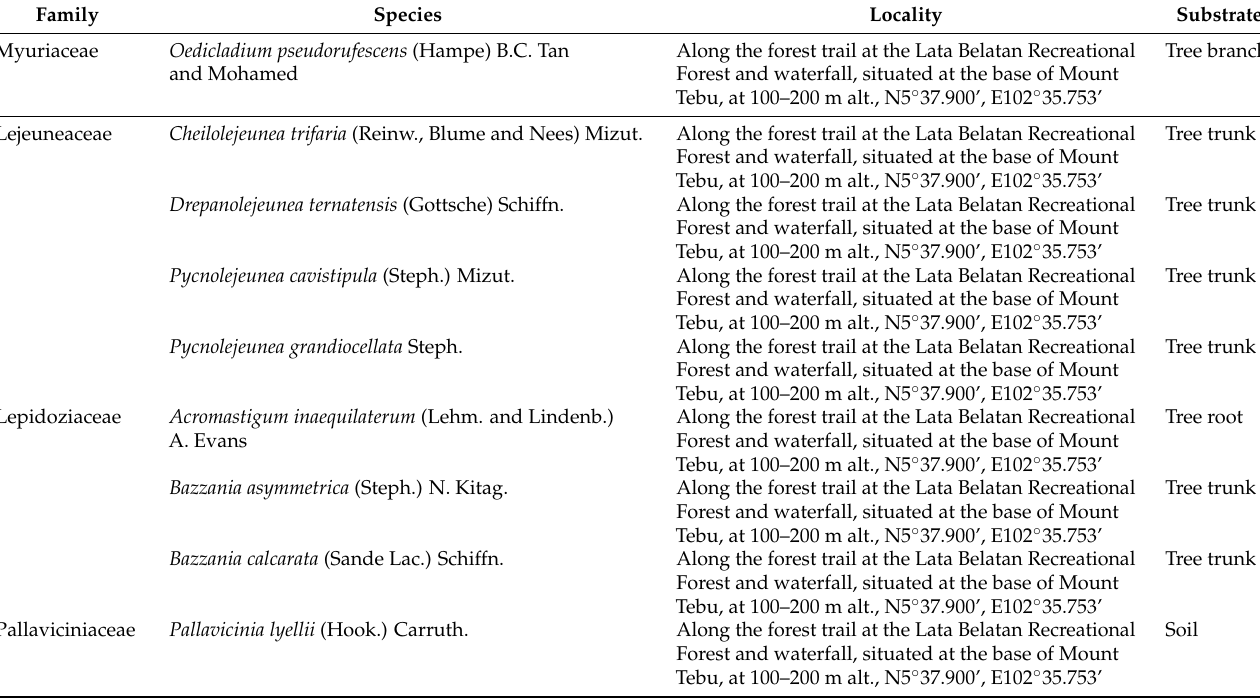
In nine bryophyte species of Lata Belatan (Table 3), 3 to 11 compounds were identified, accounting for 93.1% to 99.9% of total volatiles (Table 4). Naphthalene ( 6 ) was found to be the most abundant volatile component in the liverworts Pycnolejeunea cavistipula (68.9%), Drepanolejeunea ternatensis (67.9%), Pallavicinia lyellii (62%) and the moss Oedicladium pseu- dorufescens (67.9%). Alkane dominated Pycnolejeunea grandiocellata , Bazzania calcarata and Acromastigum inaequilaterum , which accounted for 54.3%, 57.8% and 58.3% of total peak areas, respectively. 1-dodecene and 1-tetradecene ( 1 ) were dominant in B. asymmetrica , representing 76.4% of total volatiles. Table 3. Bryophyte species from Lata Belatan with information on the family and species name, collecting locality and